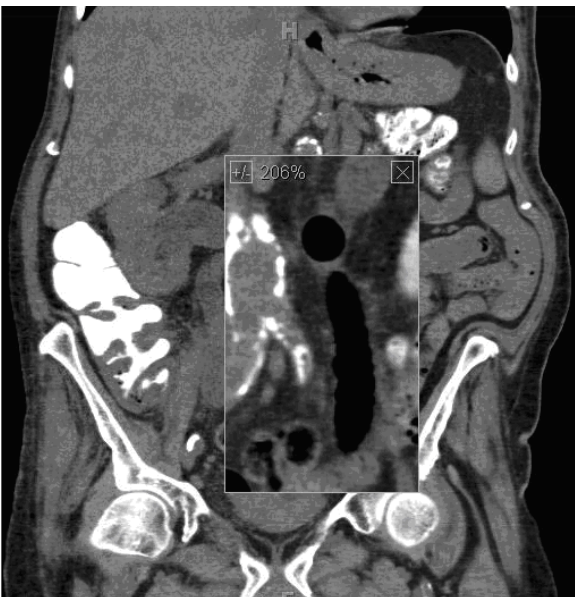
Figure 3 - Coronal reconstruction (206 % enlargement of area of interest) at a slightly more posterior level shows the entire left ureter dilated by